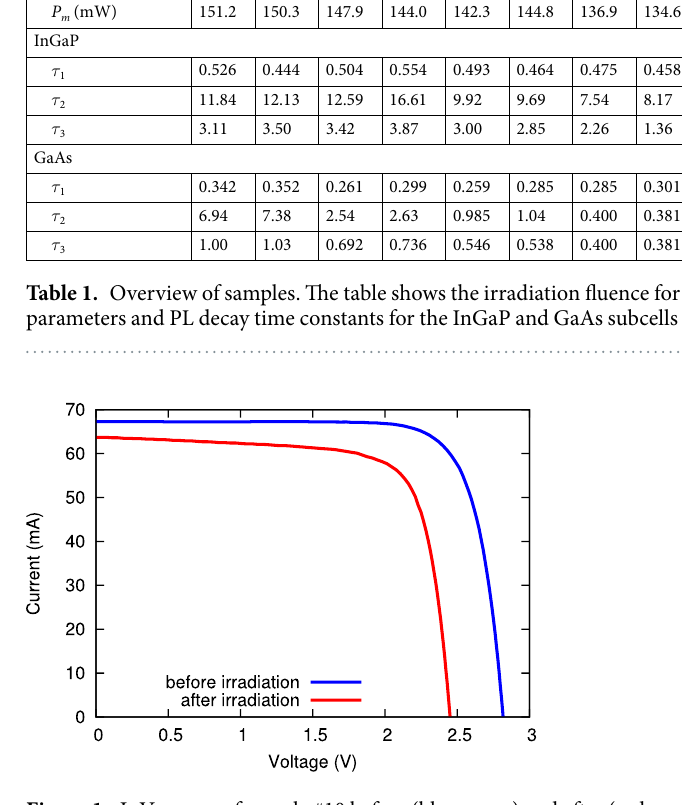
Figure 1. I–V curves of sample #10 before (blue curve) and after (red curve) electron irradiation. Due to strong electron irradiation, both I sc and V oc dropped. Also the fill factor changed